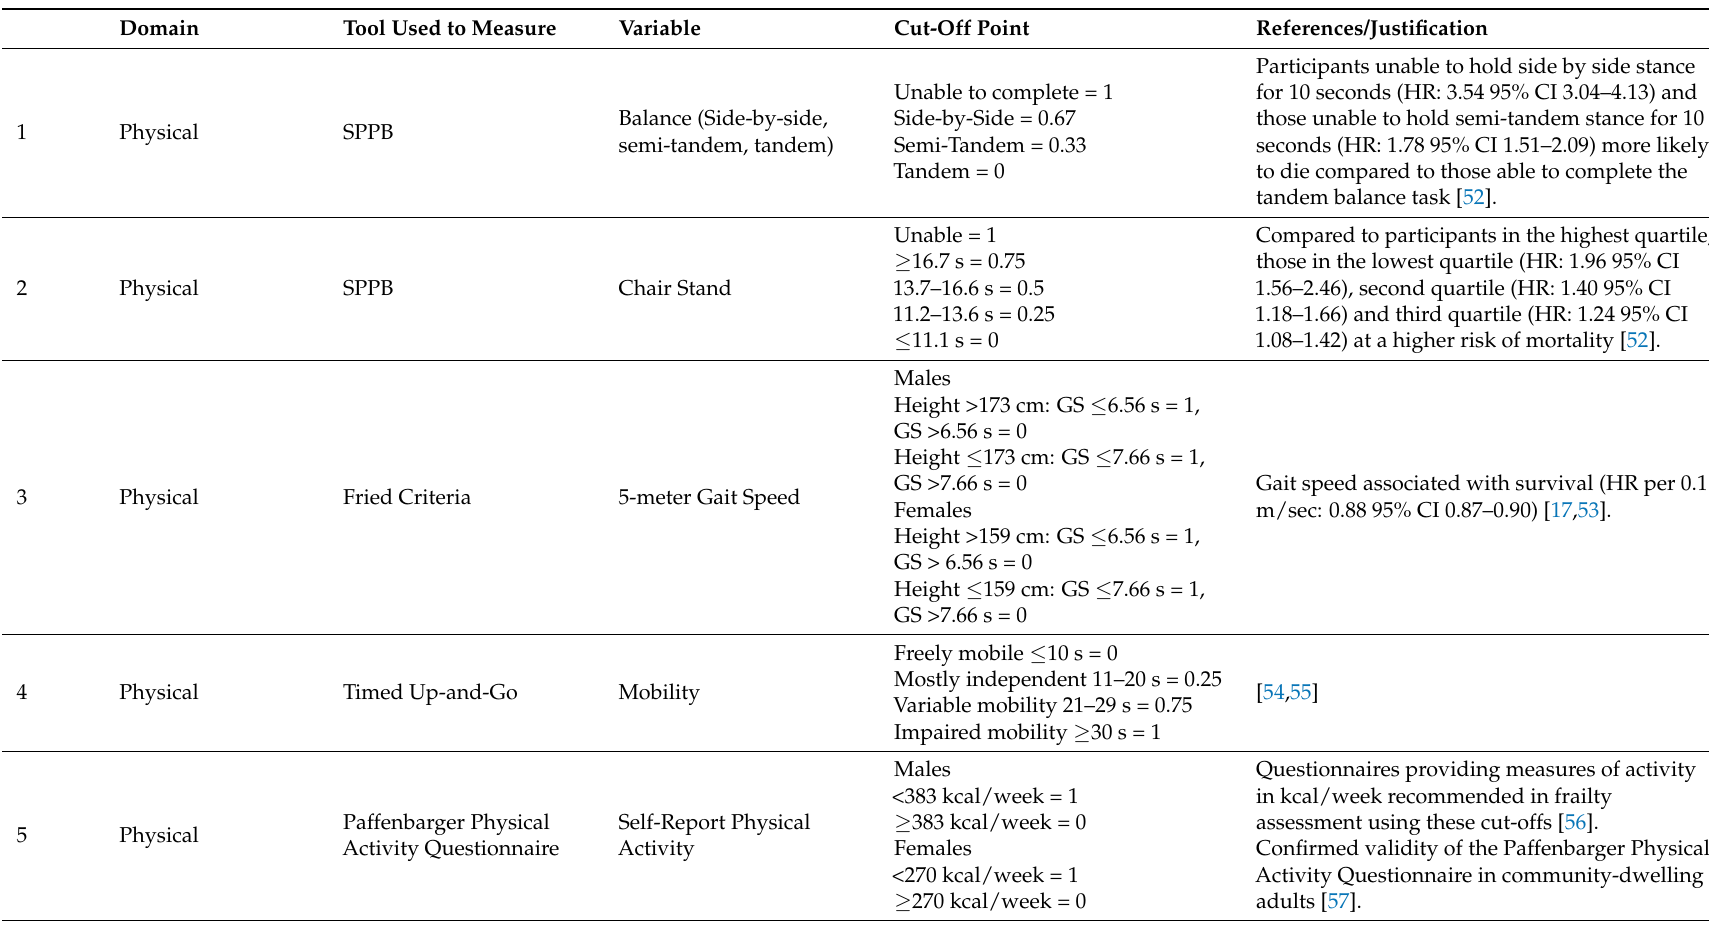
Table A1. Functional frailty index